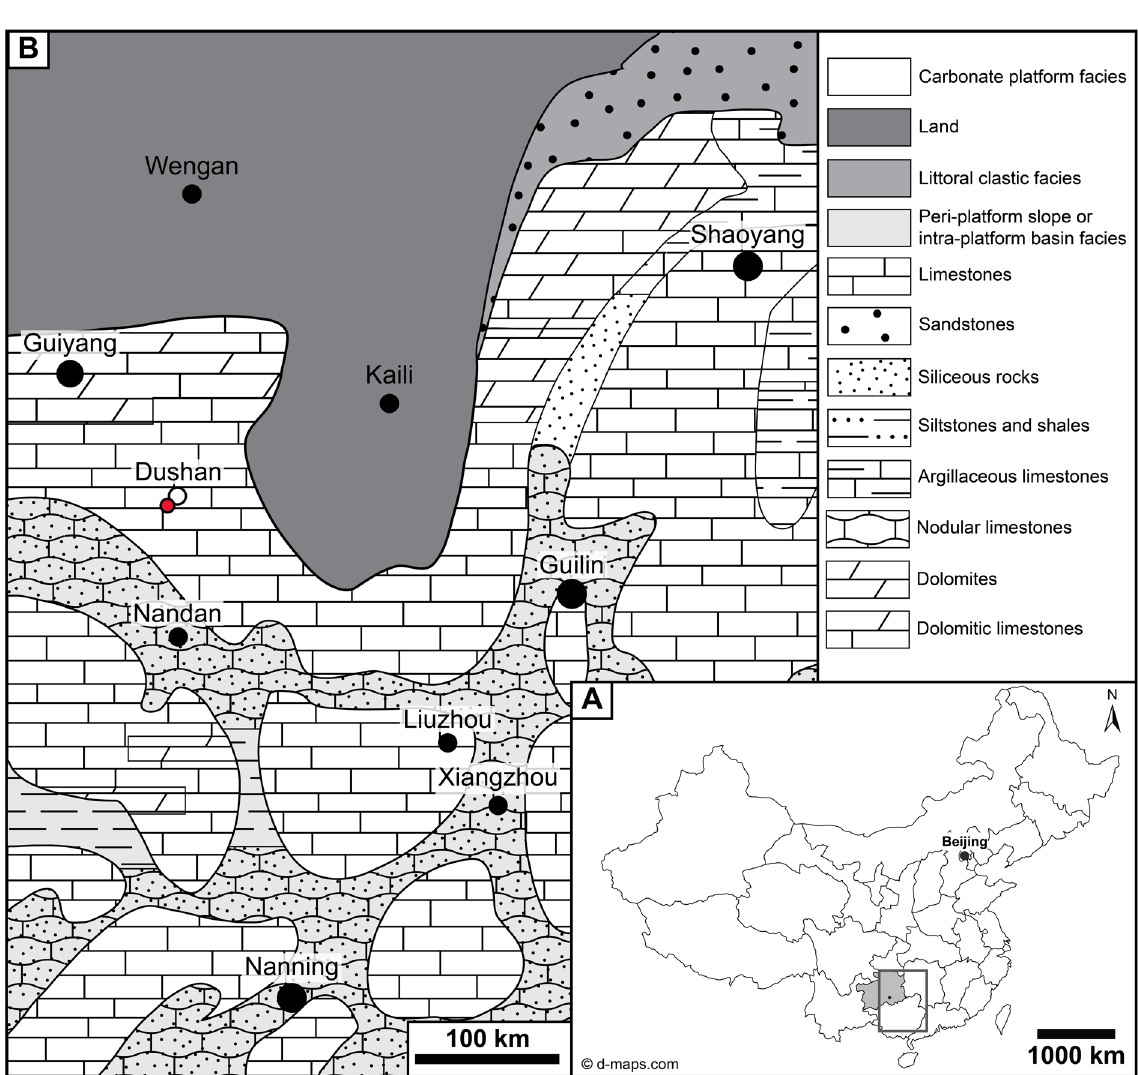
Fig. 2. A . Location map of the Guizhou Province in China. B . Geological map of the Blue Snake Section and its surroundings (modified after Song & Gong 2019 and Ma et al. 2016). The red spot indicates the location of the Blue Snake section and the black circle indicates the location of Dushan